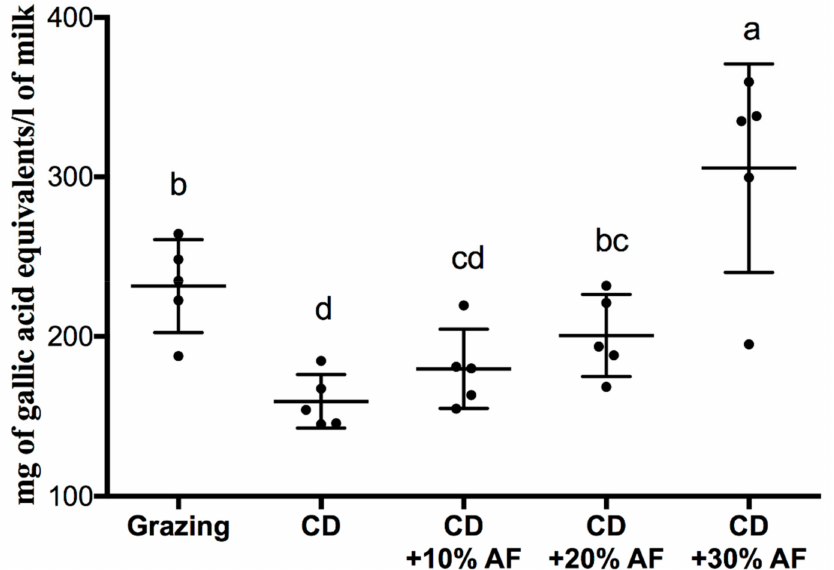
Figure 1. Total polyphenols of freeze-dried milk from goats fed conventional diet versus diets supplemented with graded levels of Acacia farnesiana pods (AF). CD = Conventional diet. a,b,c,d Means with di ff erent letters indicate di ff erences ( p < 0.05) among